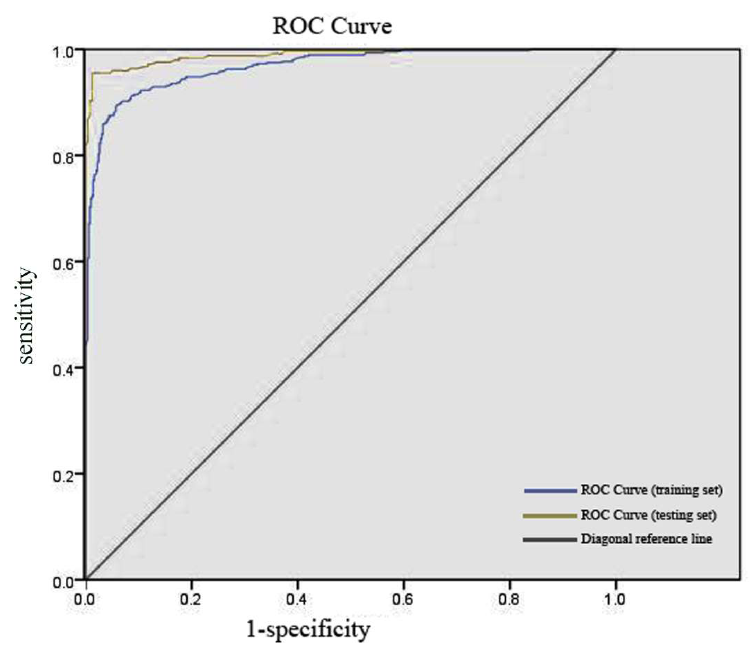
Figure 3. The receiver operator characteristic (ROC) curves for the optimal random forest (RF) model.